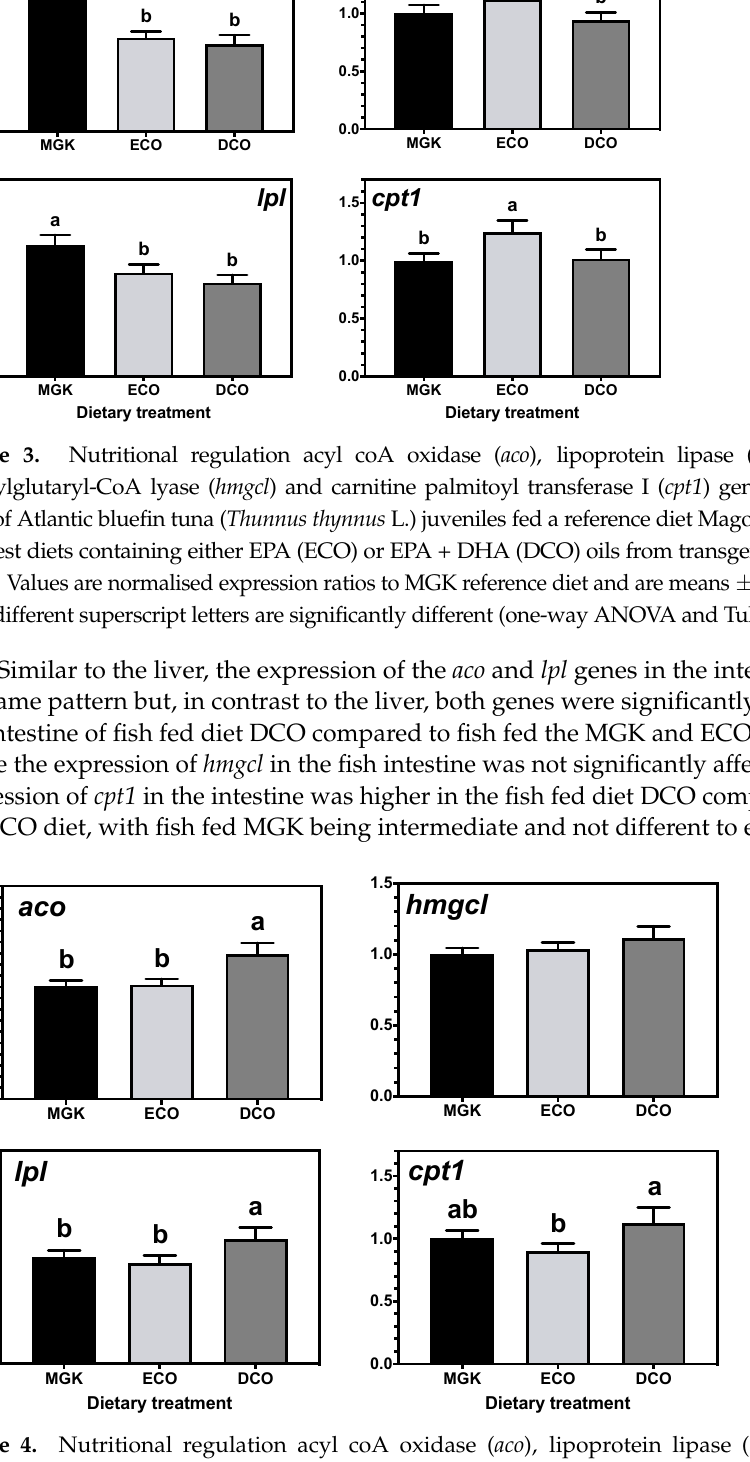
Figure 4. Nutritional regulation acyl coA oxidase ( aco ), lipoprotein lipase ( lpl ), 3-hydroxy-3- methylglutaryl-CoA lyase ( hmgcl ) and carnitine palmitoyl transferase I ( cpt1 ) gene transcription in intestine of Atlantic bluefin tuna ( Thunnus thynnus L.) juveniles fed a reference diet Magokoro ® (MGK) and two test diets containing either EPA (ECO) or EPA + DHA (DCO) oils from transgenic Camelina sativa seeds. Values are normalised expression ratios to MGK reference diet and are means ± SD ( n = 6). Values with different superscript letters are significantly different (one-way ANOVA and Tukey test; p < 0.05).